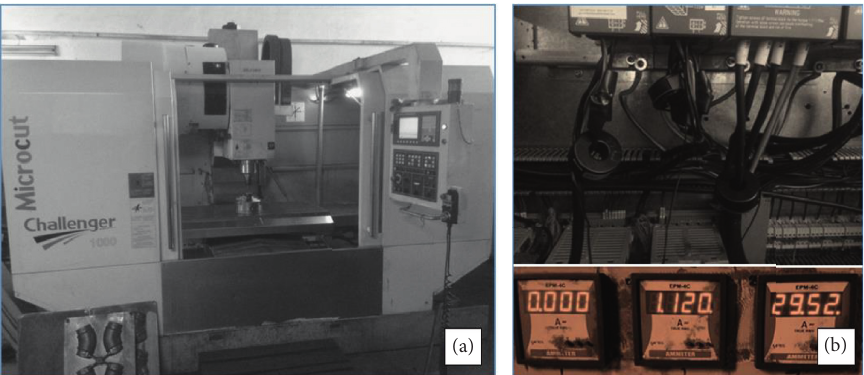
Figure 1: (a) Microcut 1000 CNC machining center. (b) Ammeter and current transformer drive connection. Table 3: Experimental surface roughness results and S / N ratios.